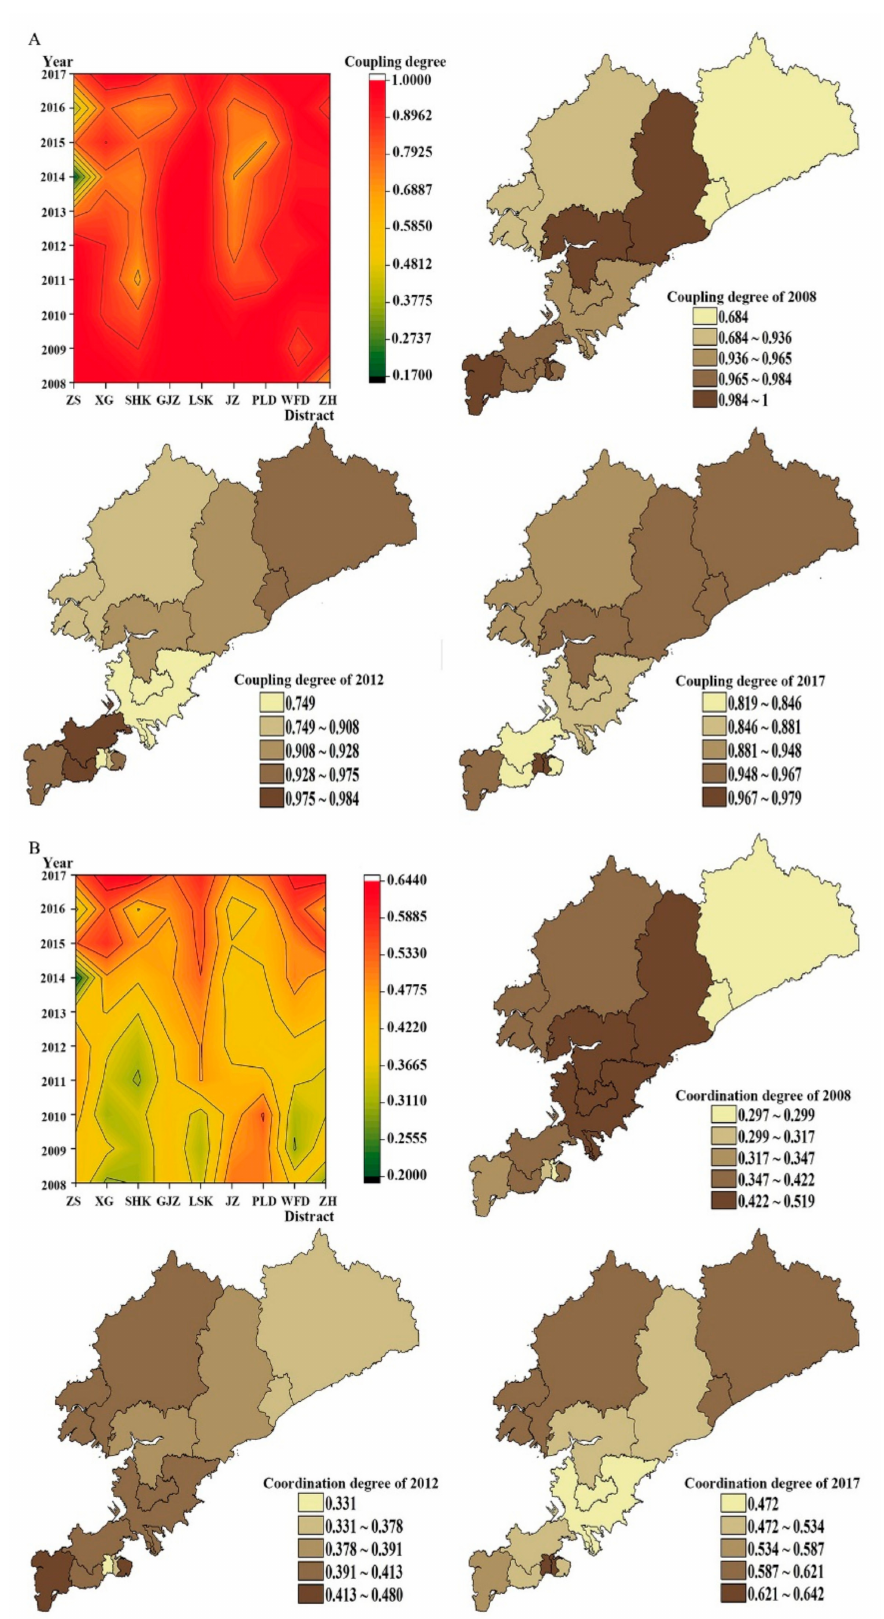
Figure 3. Change trend of coupling degree and coordination degree between urban and rural